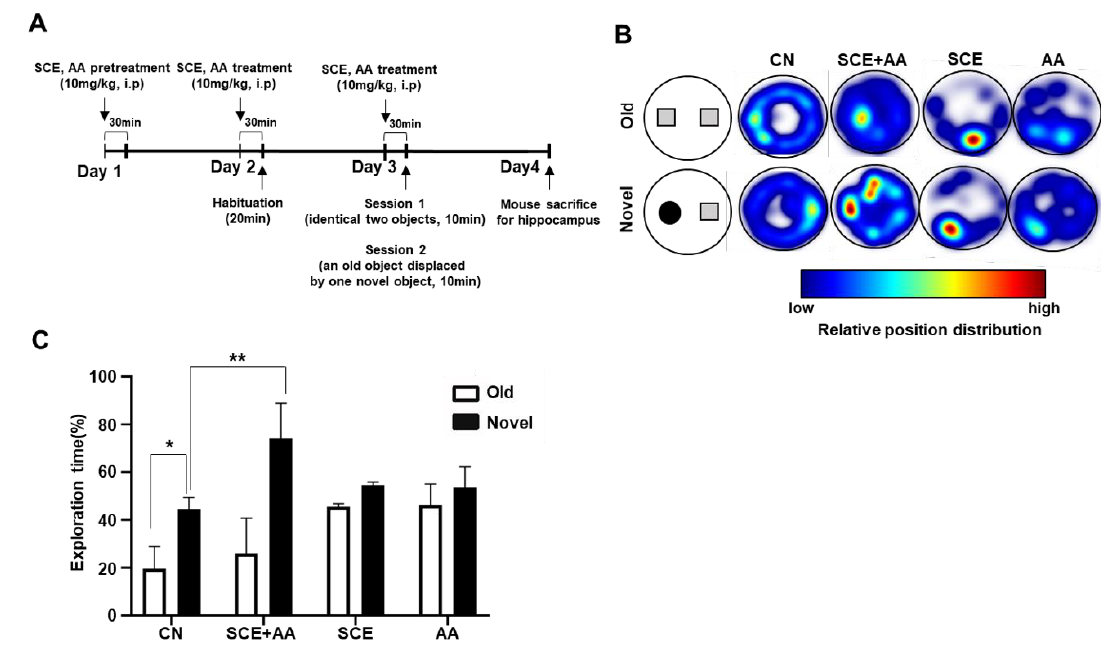
Figure 3. Injection of SCE-AA mixture enhances recognition memory in mice. ( A ), Experimental time-line of the novel object-recognition (NOR) test. ( B ), Heat-map image of the NOR test. ( C ), Exploration time was calculated as a percentage of total test time. Results are presented as means ± SD of three experiments ( n = 5/group, * p < 0.05 vs. corresponding controls).